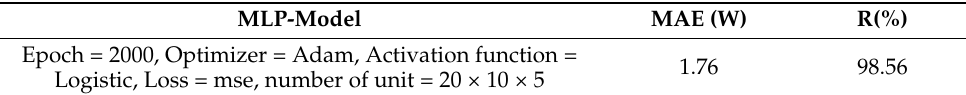
Table 3. Error metrics of the NN model used for fault